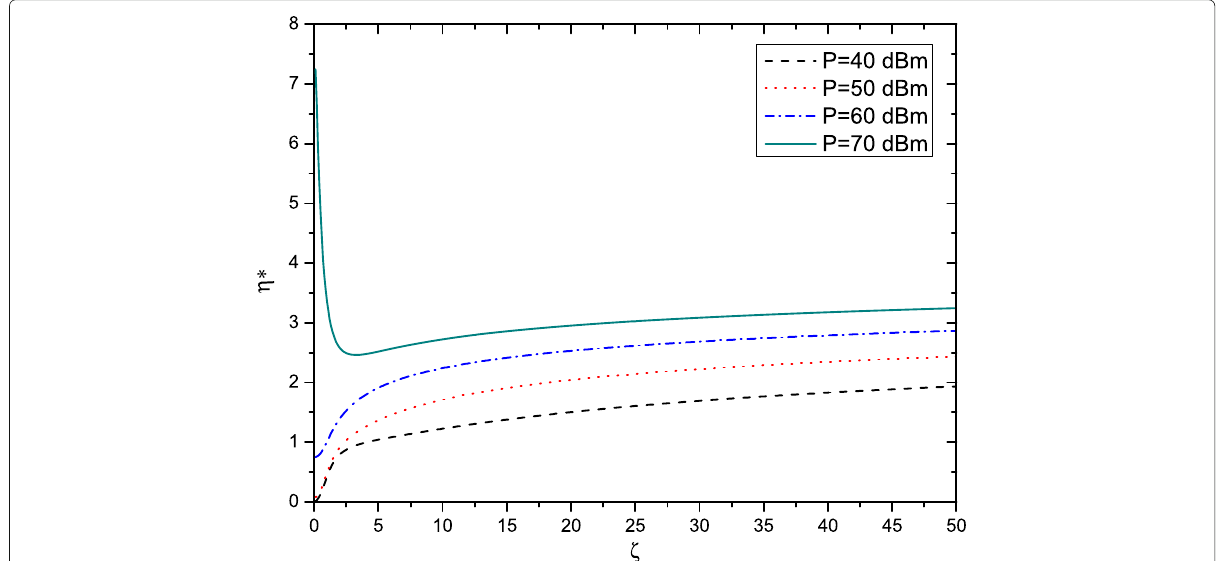
Fig. 4 The value of η ∗ versus ς with different P when r = 0.9, h = 8.335 × 10 − 7 , and σ =